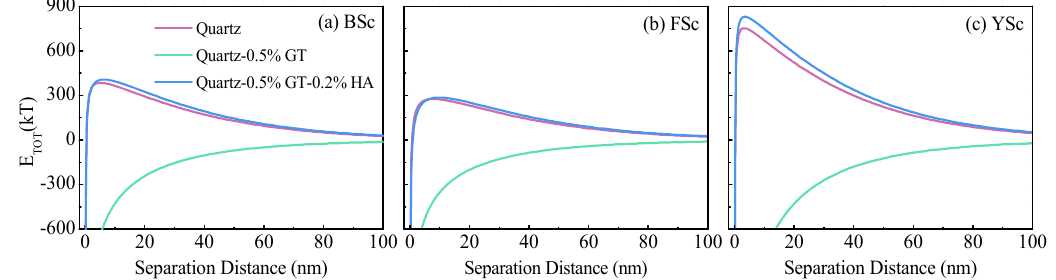
Figure 4. DLVO interaction energy (E TOT ) between soil colloids and sand (purple lines), sand coated with 0.5% goethite (GT) (green lines), and sand coated with 0.5% GT plus 0.2% humic acid (HA) (blue lines) for ( a ) black soil (BS), ( b ) fluvo-aquic soil (FS), and ( c ) yellow soil (YS). The E TOT is expressed in kT, where k is the Boltzmann constant and T is the absolute temperature in Kelvin.